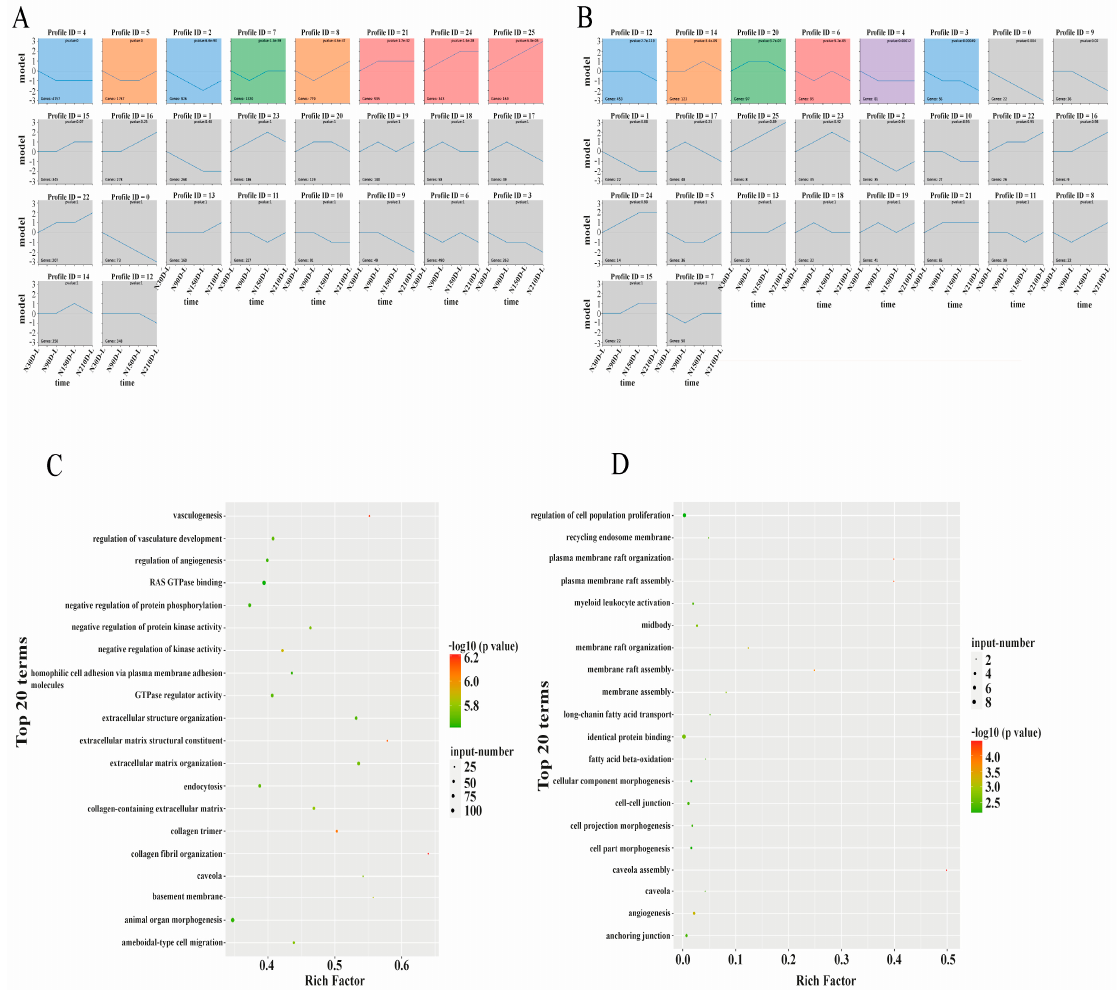
Figure 4. Short Time-series Expression Miner identified temporal expression profiles of ( A ) mRNAs and ( B ) lncRNAs. Top panel shows module number. Numbers at top right corner of panels represent the p -value and numbers at the bottom left indicate lncRNAs or mRNAs in each profile module. Profiles with same color are grouped in the same cluster. Distribution diagram of Gene Ontology functions of ( C ) mRNAs and ( D ) lncRNAs in STEM analysis.